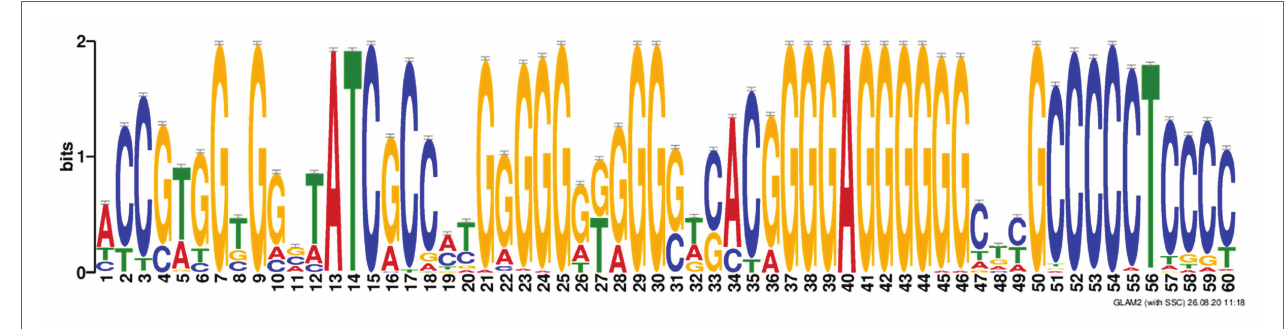
FIGURE 4 | Alignment of the ±100 nucleotide context of the repetitive PQSs in the genomes of Methanomicrobiaceae family revealed a C-rich motif at 3 ' -end of the PQS. Discovered motif in Methanomicrobiaceae’s performed with GLAM2.